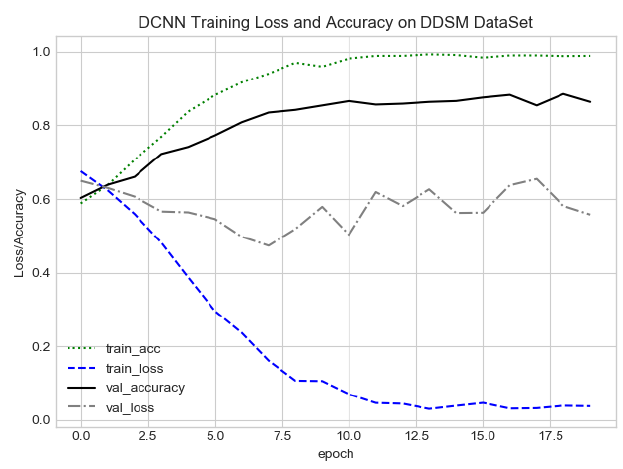
Figure 10. FC-DSCNN training loss and accuracy on the DDSM dataset.